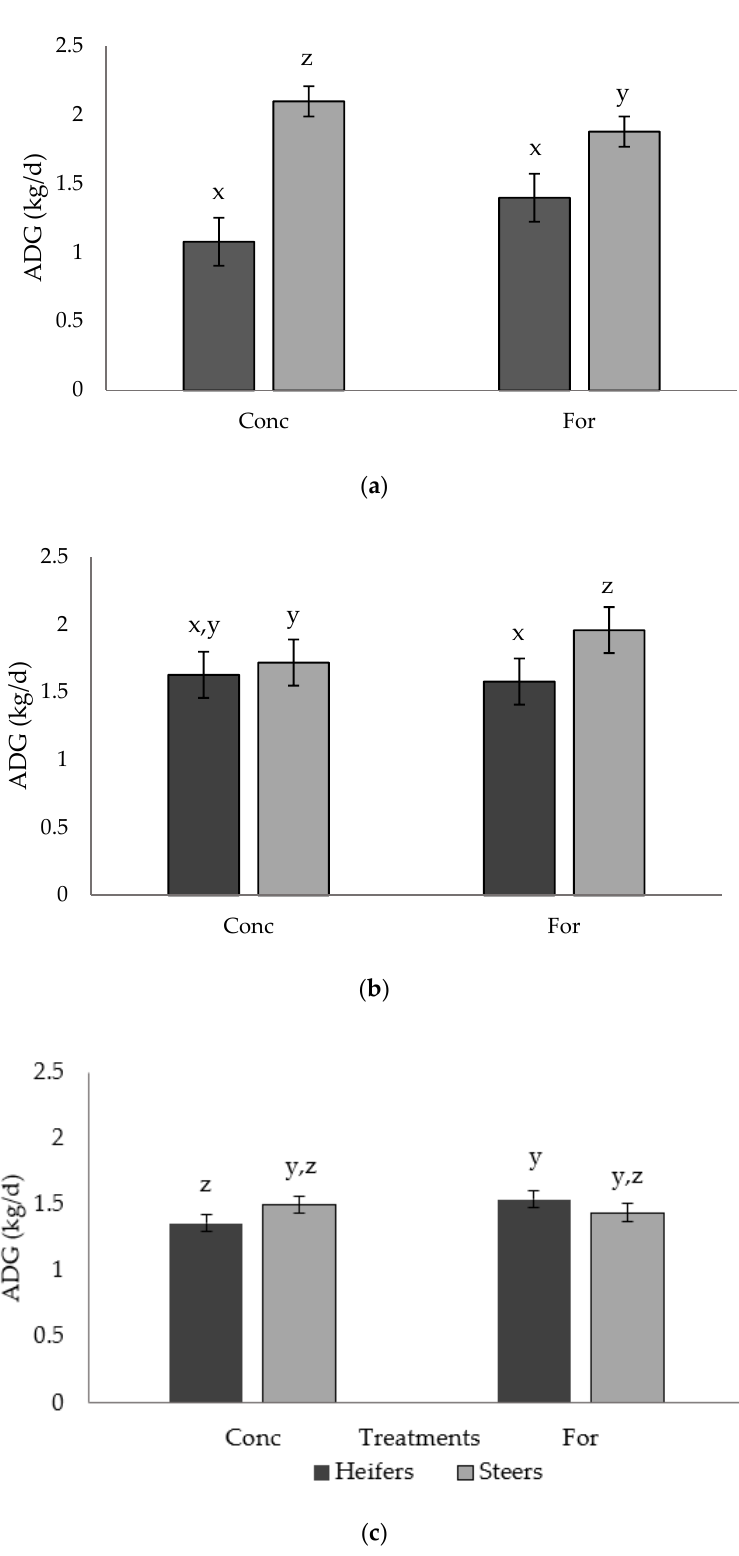
Figure 1. Treatment by sex interaction for ADG (kg/d) of progeny in: ( a ) Period 2 ( p = 0.054), ( b ) Period 3 ( p = 0.071), and ( c ) Period 5 ( p = 0.067) from dams fed a concentrate-based (Conc) or forage- based (For) diet during mid- and late-gestation. Diets formulated based on NRC (2000) requirements for dams fed either a concentrate or forage diet during mid- and late-gestation. x, y, z LSmeans lacking a common superscript differ ( p ≤